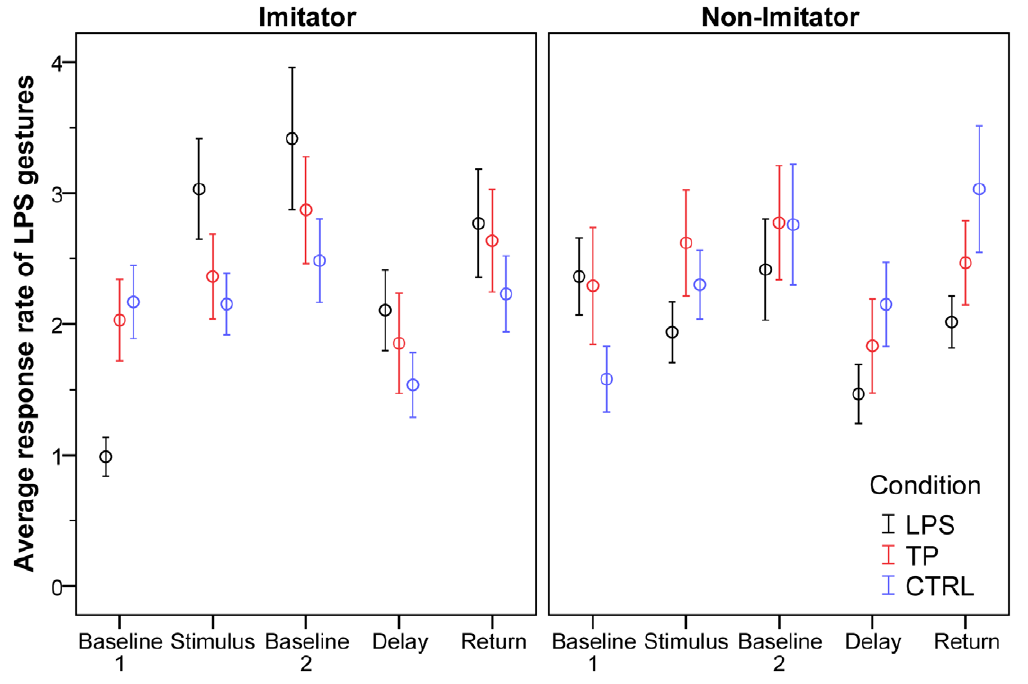
Figure 2. Average response rates of LPS per 40 sec + / 2 SEM broken down into Imitators (left, N=33) and Non-imitators (right, N=27) in LPS, TP, and CTRL conditions across time periods.